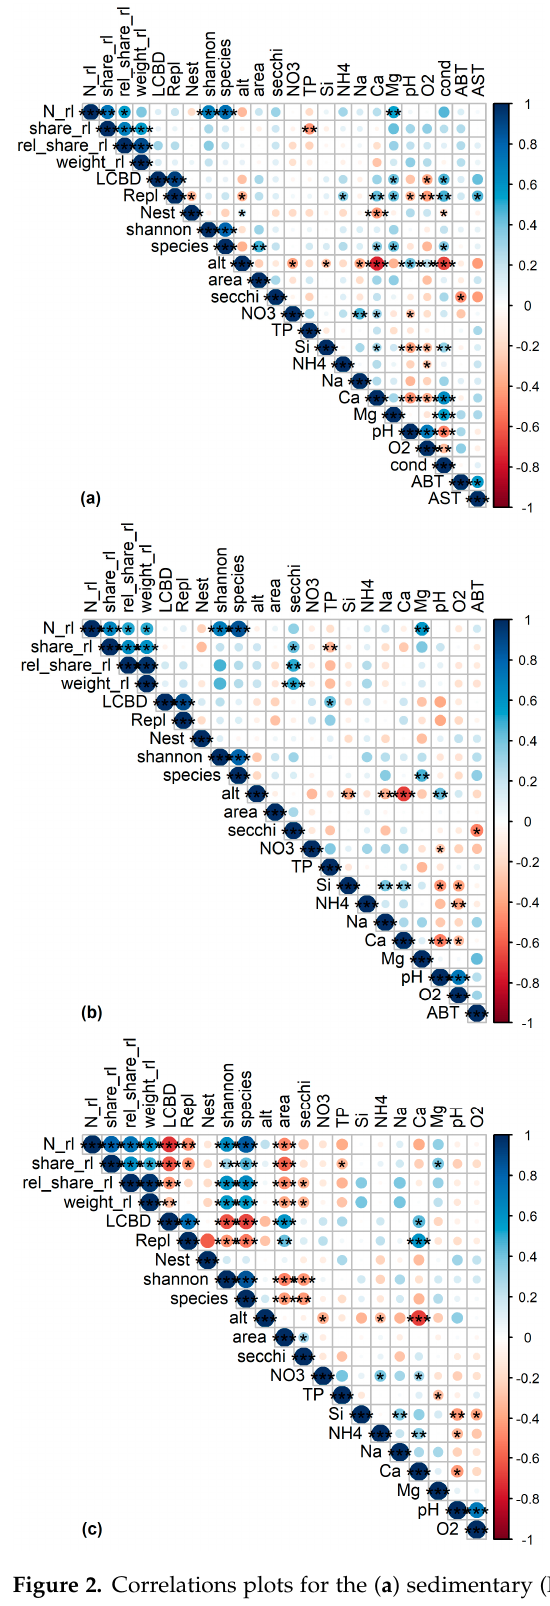
Figure 2. Correlations plots for the ( a ) sedimentary (N = 43), ( b ) littoral (N = 34) and ( c ) planktic (N = 32) diatom dataset. Abbreviations of environmental parameters are explained in Table S1. Asterisks: *** ˆ = p value < 0.001; ** ˆ = p value < 0.01; * ˆ = p value < 0.05. Point color refers to the Pearson correlation